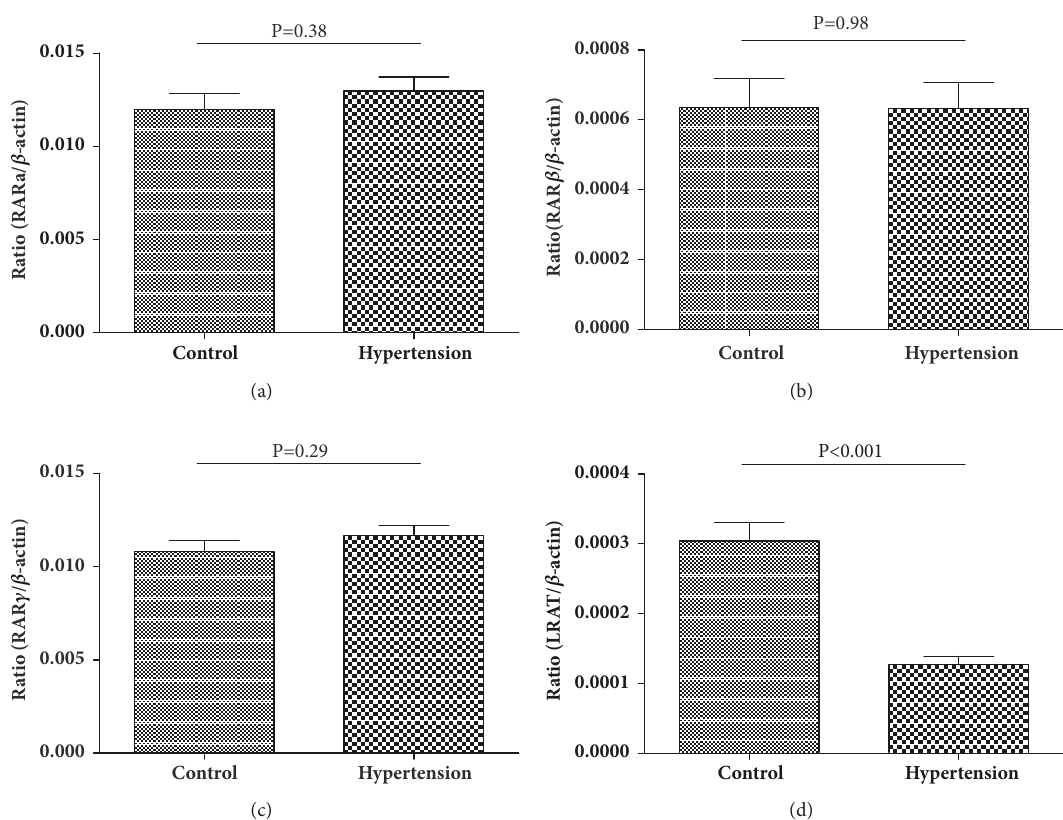
Figure 1: The level of RAR 𝛼 , RAR 𝛽 , RAR 𝛾 and LRAT mRNA expression (n=164). (a) The level of RAR 𝛼 mRNA expression (Ratio (RAR 𝛼 / 𝛽 - actin)) between the hypertension and control groups, P=0.38. (b) The level of RAR 𝛽 mRNA expression (Ratio (RAR 𝛽 / 𝛽 -actin)) between the hypertension and control groups, P=0.98. (c) The level of RAR 𝛾 mRNA expression (Ratio (RAR 𝛾 / 𝛽 -actin)) between the hypertension and control groups, P=0.29. (d) The level of LRAT mRNA expression (Ratio (LRAT / 𝛽 -actin)) between the hypertension and control groups, P < 0.001.